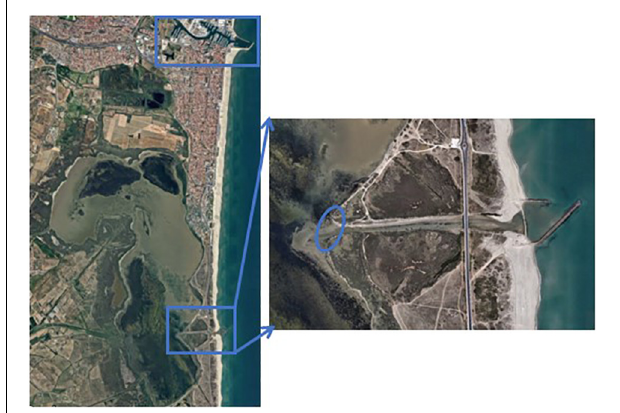
FIGURE 1 | Lagoon of Canet-Saint Nazaire (below) and port of Canet (above) indicating the sampling site (Google Maps, 2018).